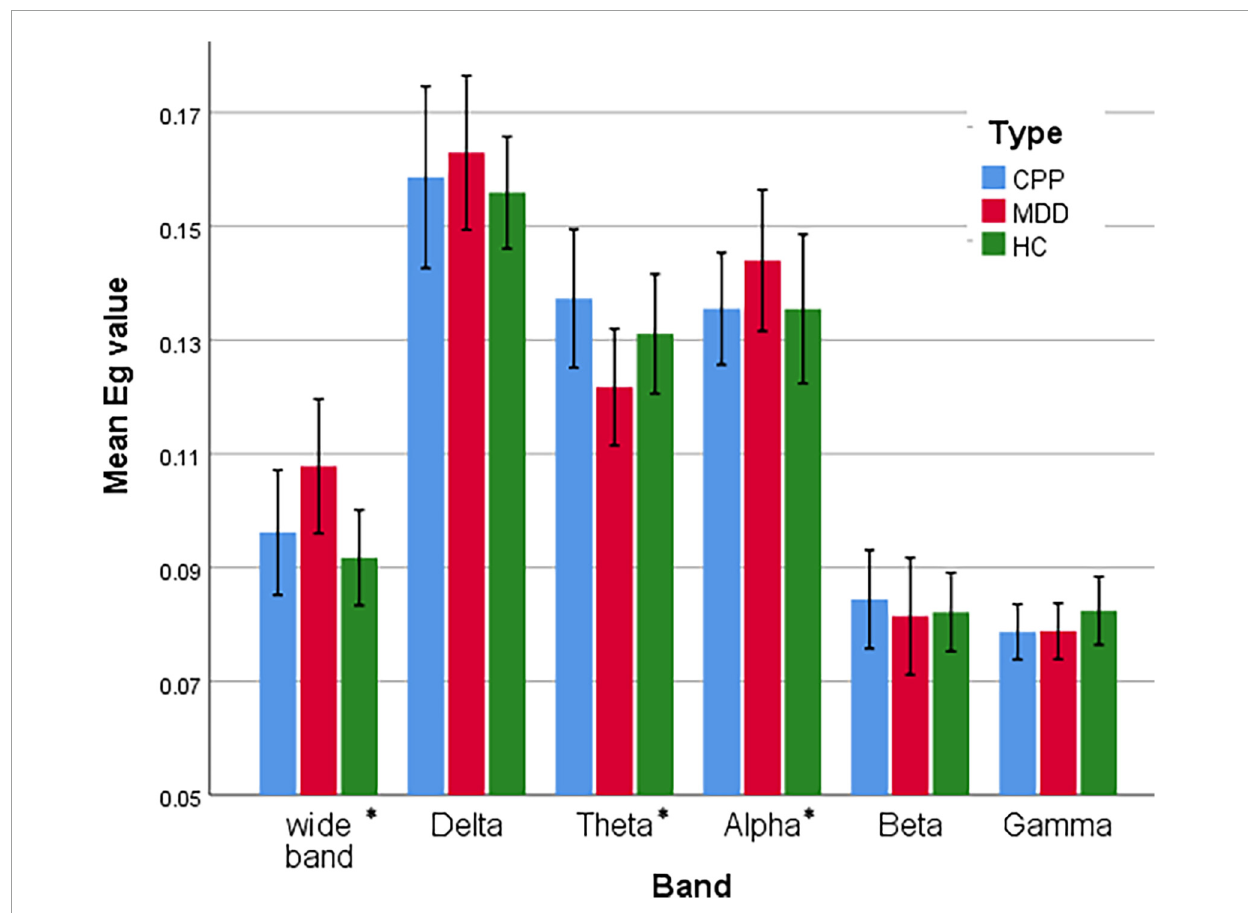
FIGURE6 Statistical comparison chart of overall efficiency of three groups of people in six frequency bands. The error interval takes the value of 95%. * P <